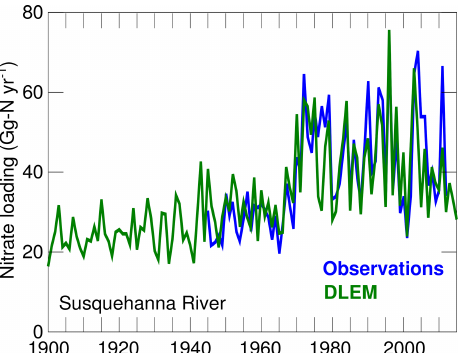
Figure 4. Long-term changes in the nitrate loading of the Susque- hanna River. Observations are from Harding et al. (2016) (their Fig. 7) while model values are from DLEM (see Methods